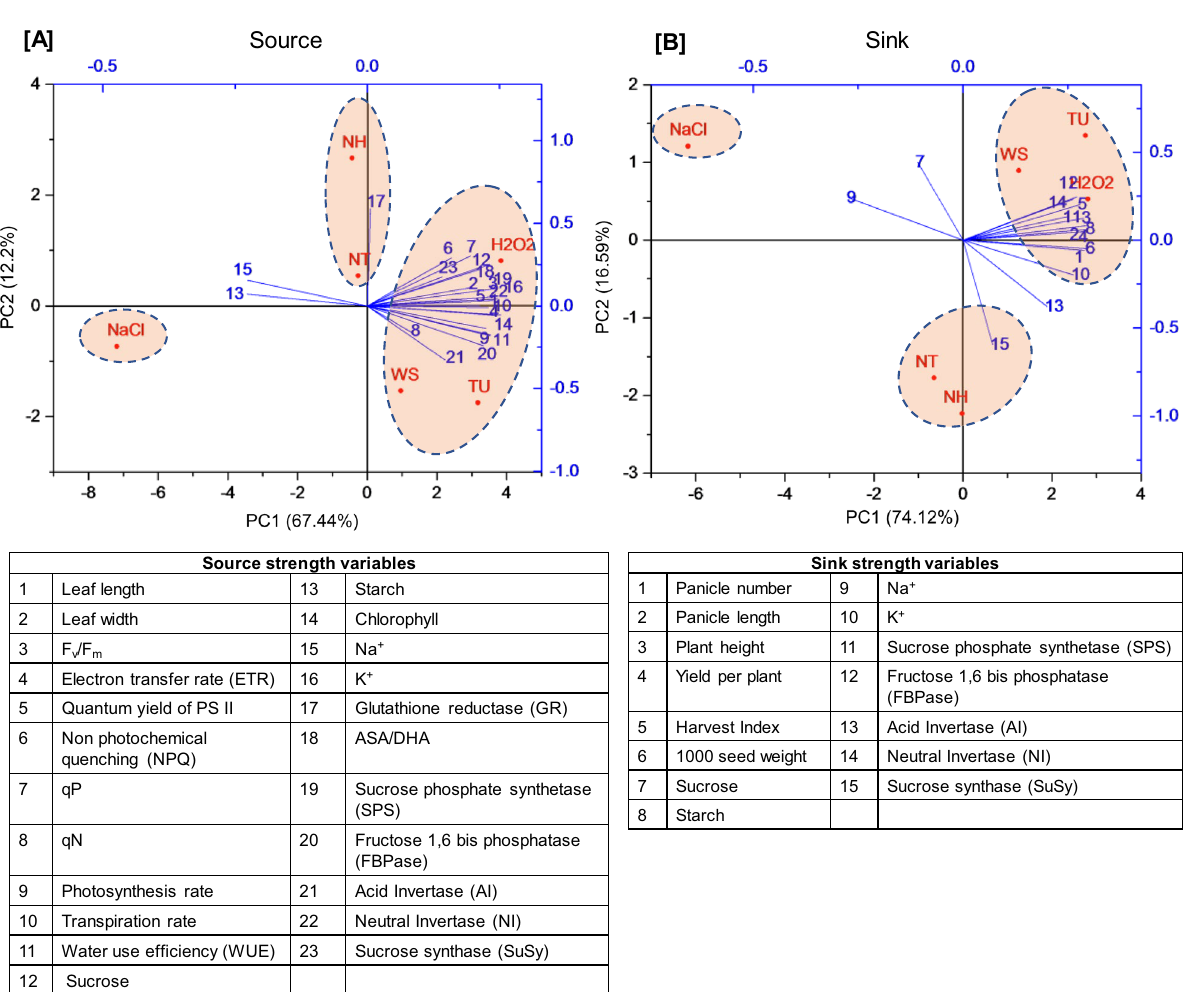
Figure 7. Principal component analysis on field grown plants to understand treatment-variable interaction. The principal component analysis (PCA) was performed to identify the variables associated with different treatments including WS (DW + 0.01% Tween-20), TU (6.5 mM TU + 0.01% Tween-20) and H 2 O 2 (10 mM H 2 O 2 + 0.01% Tween-20), NaCl (22 g NaCl per pot). NT and NH denote combined treatment of NaCl + TU and NaCl + H 2 O 2 treatments, respectively. The biplots were generated independently for young leaf (source; A ) and developing inflorescence (sink; B ) using the variables responsible for mediating source and sink strength, respectively. The lines originating from central point of biplots indicate positive or negative correlations of different variables; where their closeness indicates correlation strength with particular treatment. The variables were represented in the form of numeric values with its details in associated